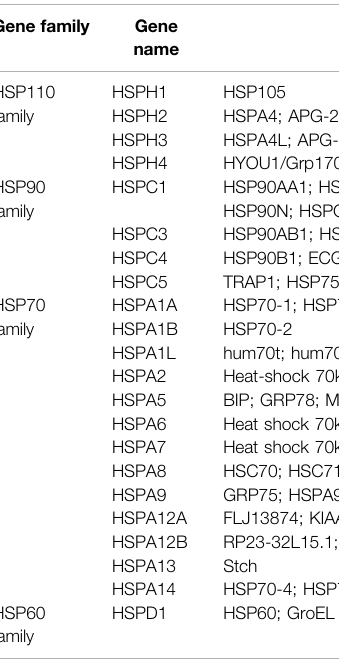
TABLE 1 | Classi fi cations of heat shock